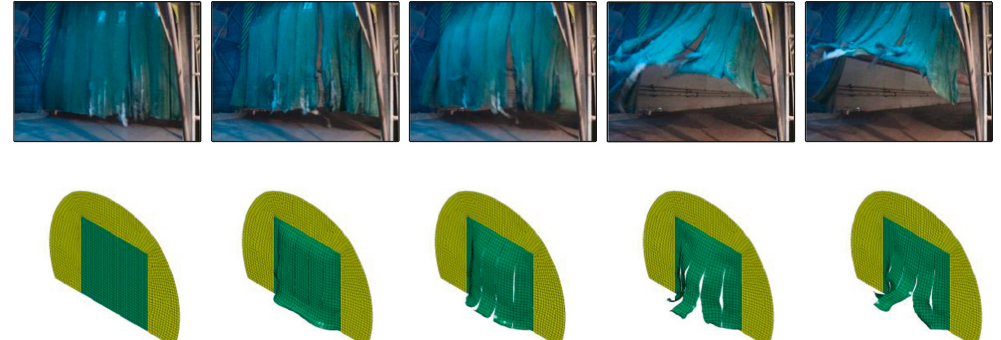
Figure 16: Processes of rigid wall and curtain during blast wave impact.